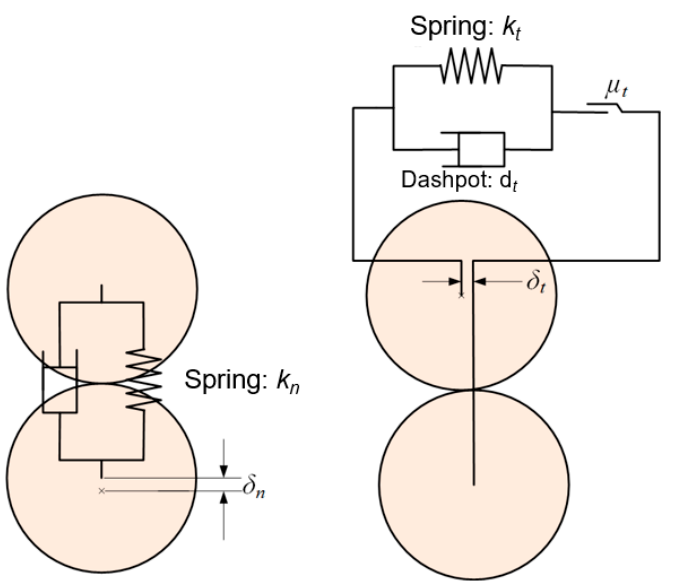
Figure 2. A schematic diagram of the normal ( left ) and tangential ( right ) components of the linear spring contact model.